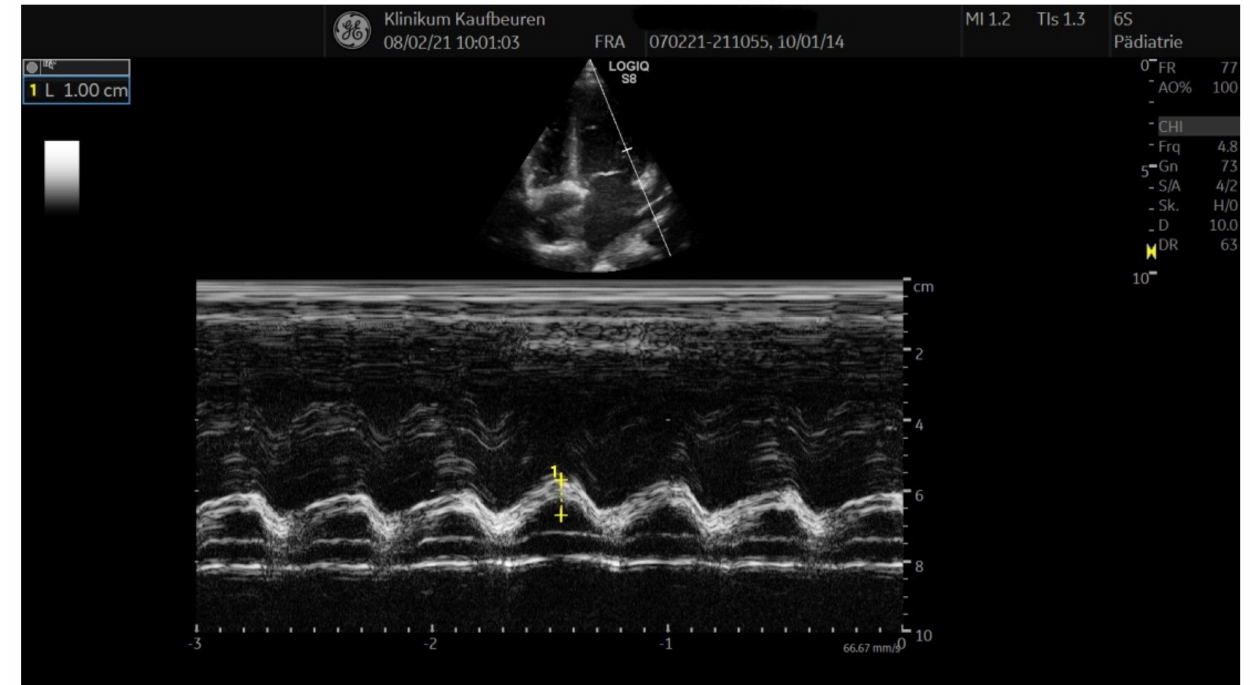
Figure 4. Diminished left ventricular function.